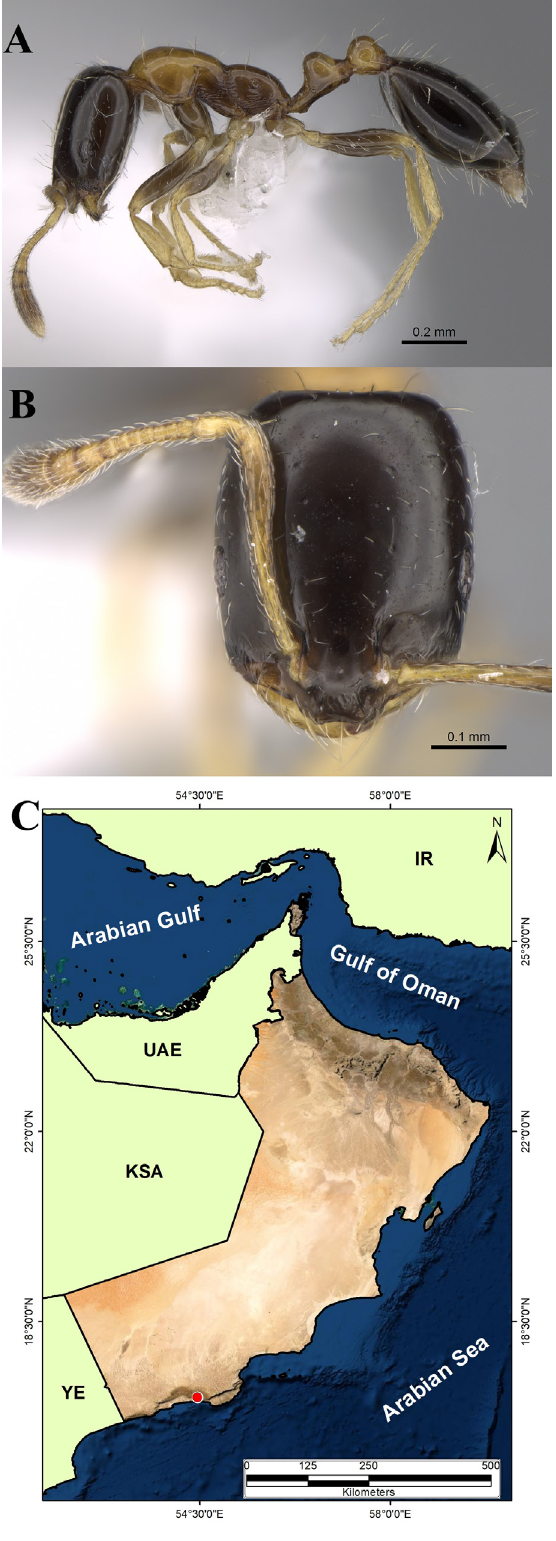
Fig. 40. Monomorium floricola (Jerdon, 1851), worker (CASENT0922876, AntWeb.org (Michele Esposito)). A . Body in profile. B . Head in full-face view. C . Distribution